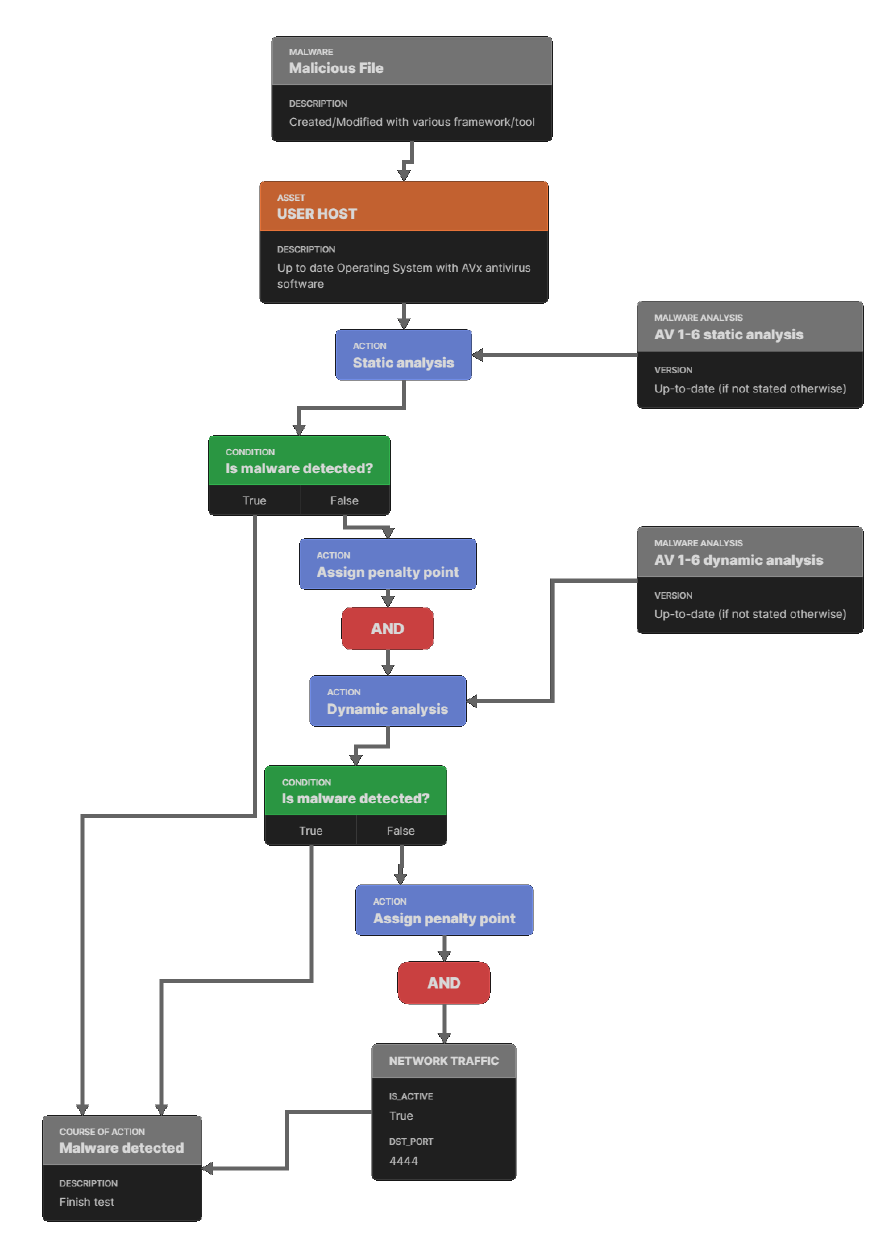
Figure 1. Attack flow and awarding of penalty points during the course of